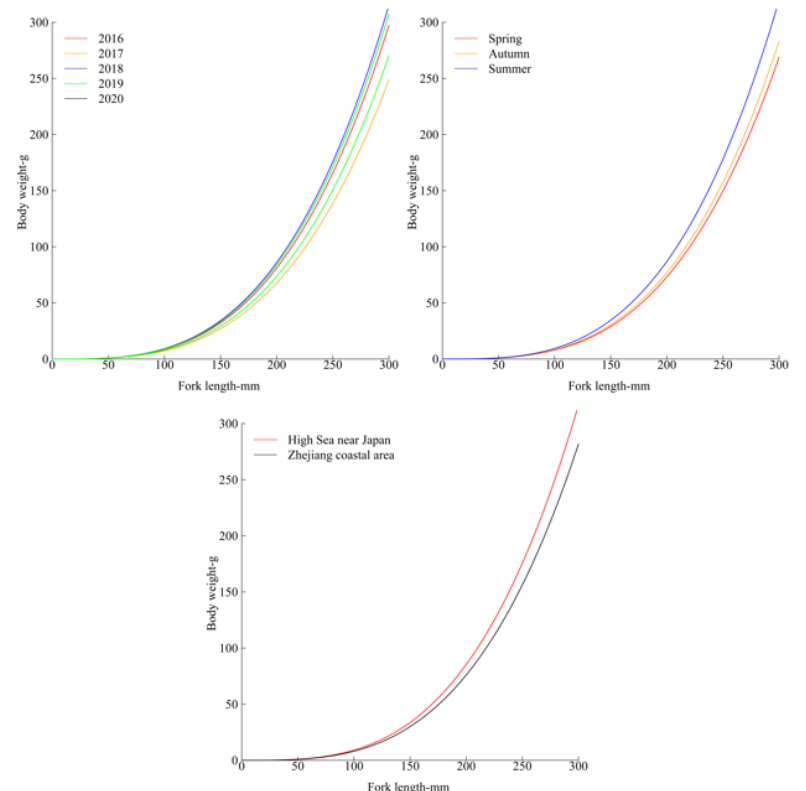
Figure 5. Fork Length-weight relationships variations by years, seasons, and regions for Chub Figure 5. Fork length–weight relationships variations by years, seasons, and regions for Chub mackerel specimens. mackerel specimens .